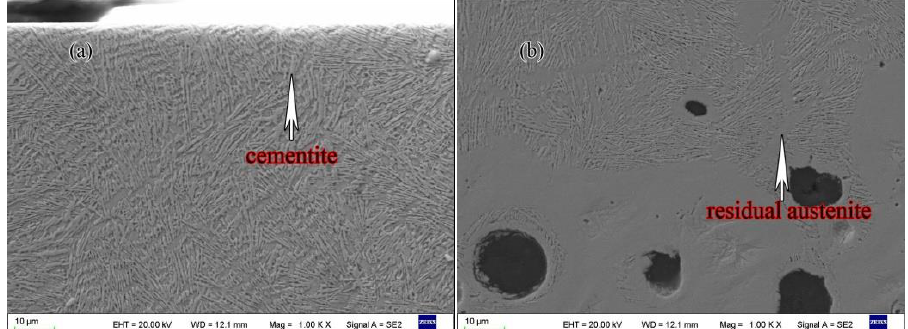
Figure 5. FISEM morphology of ductile iron treated by the plasma transferred arc: ( a ) remelted gradient layer and ( b ) heat-affected zone and substrate. The microhardness was measured along a cross-section extending over a depth of approximately 0.7 mm from the M1, as shown in Figure 6. The results indicated that the microhardness peaks were 871 HV0.2 at the M1 and decreased towards the substrate. The higher microhardness of the M1 can be attributed to the presence of fine cementite and abundant ledeburite dendrite. In the heat-affected zone, the large fraction of the residual austenite and free carbon resulted in a lower hardness compared to the M1. On enhancing the depth from the M1, the microhardness continuously decreased as the fraction of the residual austenite increased, while the fraction of the ledeburite dendrites and needle-like cementite reduced. Finally, with the depth extending to the substrate, the microhardness decreased sharply.